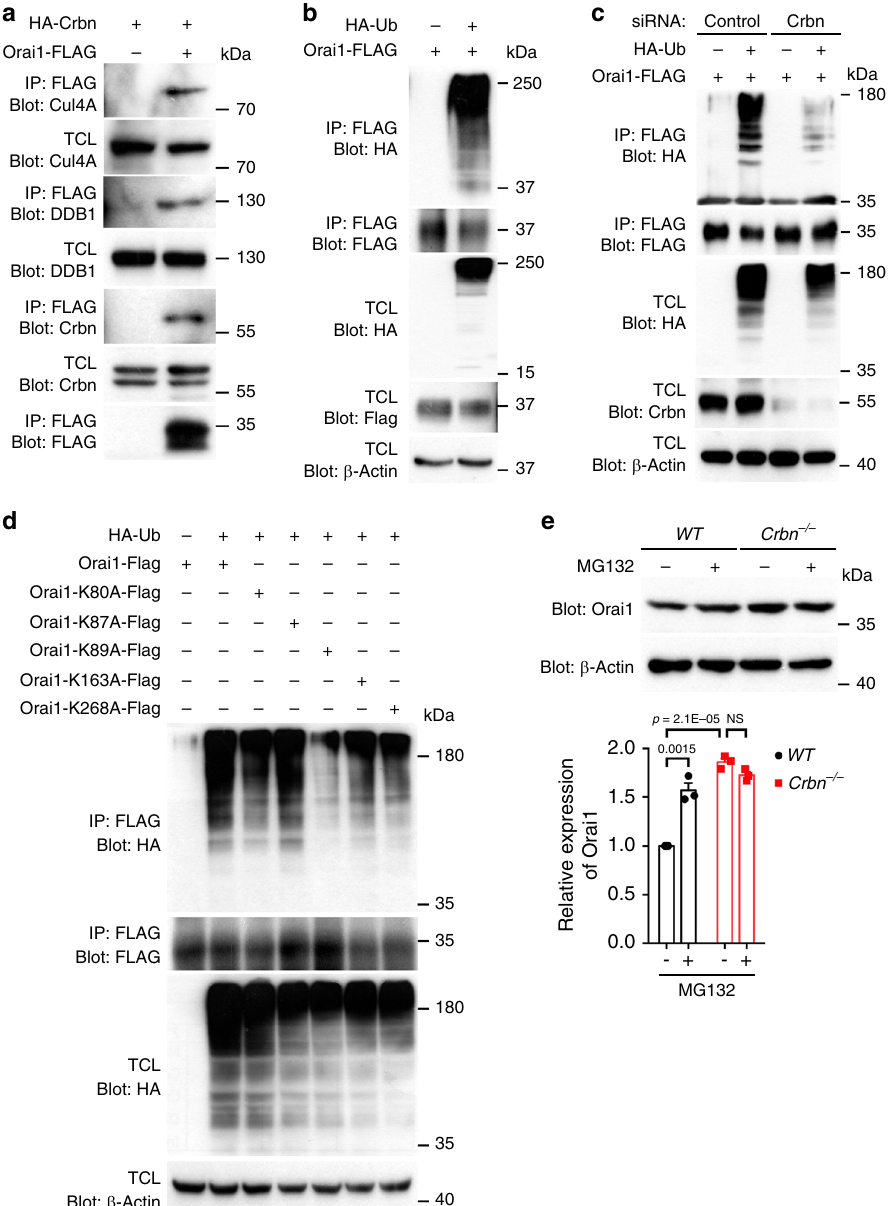
Fig. 5 Orai1 is ubiquitinated and degraded in a Crbn-dependent manner. a – d The lysates of 293T cells transfected with the indicated plasmids were incubated with anti-FLAG antibody-conjugated agarose beads. Bead-bound proteins were detected with the indicated antibodies. Data are representative of three a , c , d or four b independent experiments. e BMDMs derived from the indicated mice were treated with MG132 (5 µ M) for 6 h and then lysed. Proteins in the lysates were detected with the indicated antibodies (top) and the levels of Orai1 were quanti fi ed (bottom). n = 3 experiments, mean ± SEM. The numbers in the graph indicate p values. NS not signi fi cant (two-way